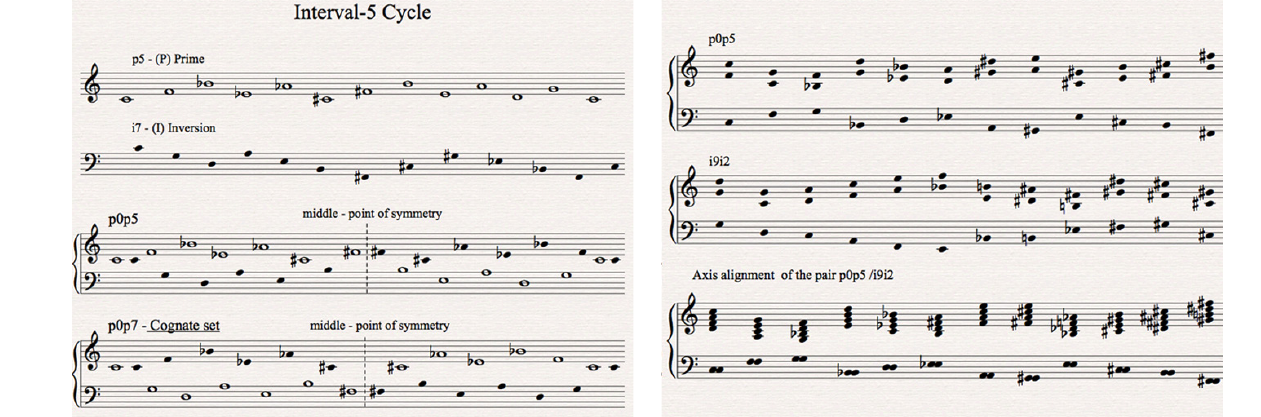
FIGURE 4 | Cognate Set. FIGURE 5 | Axis-Dyad Chord